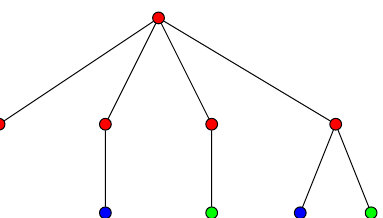
(cid:0) k − 1 (cid:1) ( j + 1) = 9 and epd( T 3 ) = 3 j =0 j